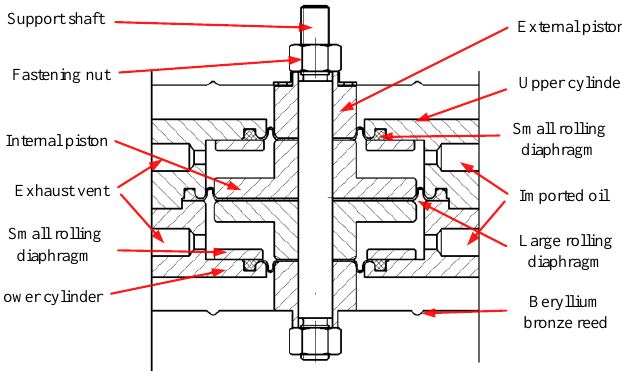
Figure 2. Schematic diagram of support cylinder.